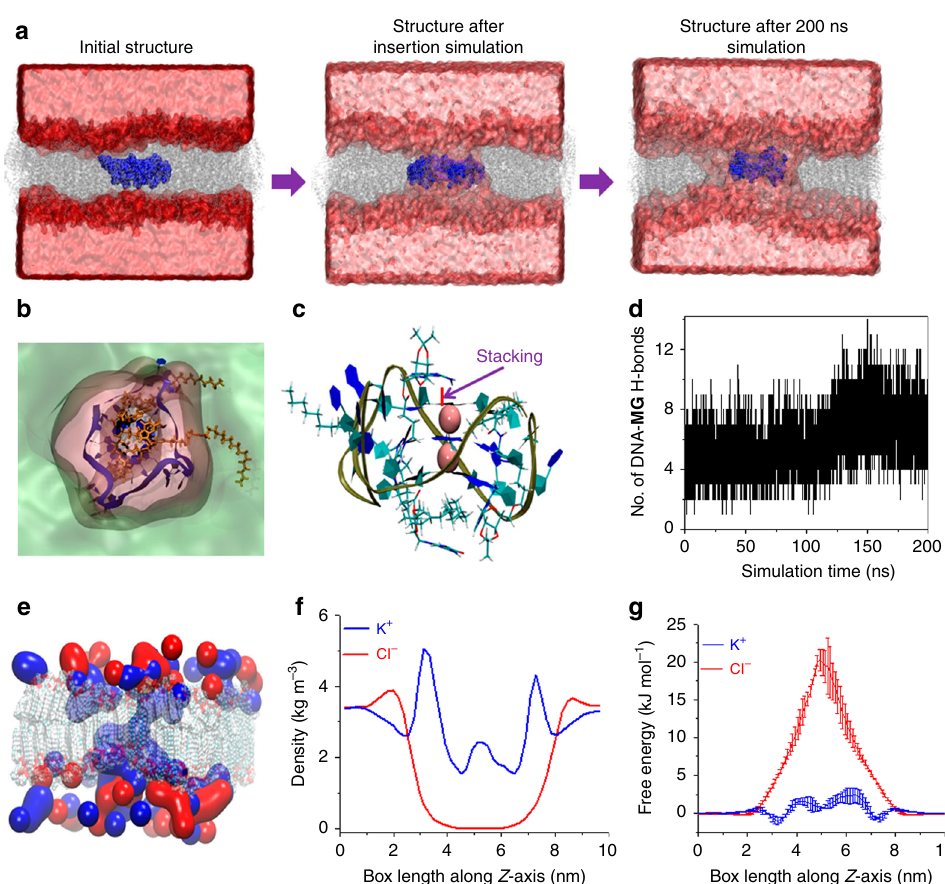
Fig. 3 MG/ h-TELO ionophore formation within lipid bilayer. a Process of pore formation around h-TELO within the lipid membrane. Initially, ligand-bound quadruplex (blue vdW representation) is placed within the lipid bilayer (gray stick) in a water box (red surface). b Final structure of the supramolecular quadruplex-based ion pore. Lipid bilayer is colored in green surface, whereas the water pore surrounding the quadruplex is shown in pink surface. h-TELO is shown in blue cartoon, and bound MG is shown in orange sticks. c Structure of MG/ h-TELO is shown. G-quadruplex is shown in cartoon representation, whereas bound ligand is shown in stick mode. d The number of hydrogen bonds between h-TELO and MG during the simulation of the ionophore is shown. e A representative snapshot of K + (blue) and Cl − (red) ion distributions in the simulation box is shown. Lipid bilayer is shown as gray transparent surface. f Density pro fi les of K + (blue) and Cl - (red) ions averaged over the entire 200 ns simulation trajectory are shown. g Potential of mean force pro fi le for K + (blue) and Cl − (red) translocation across the simulation box ( Z -axis). Source data are provided as a Source Data fi le. Data are means ± SD ( n =